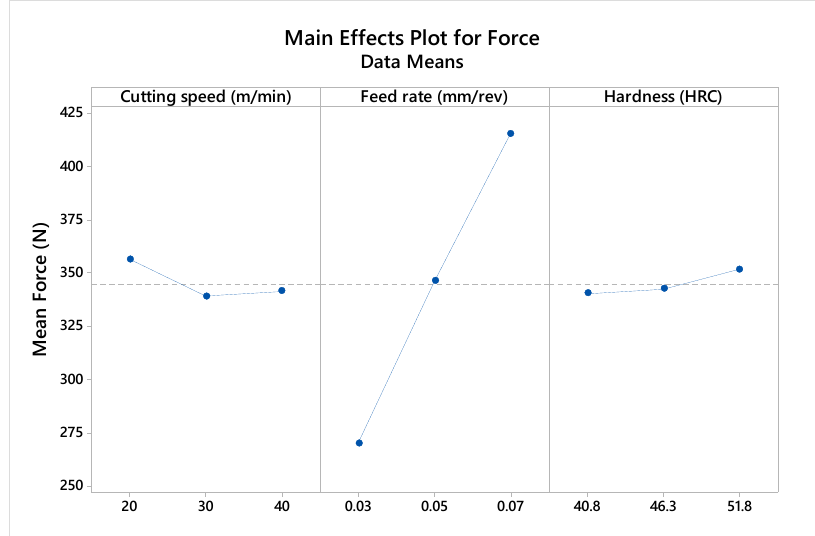
Figure 13. Main effect plot of cutting force to cutting parameters. Figure 13. Main e ff ect plot of cutting force to cutting